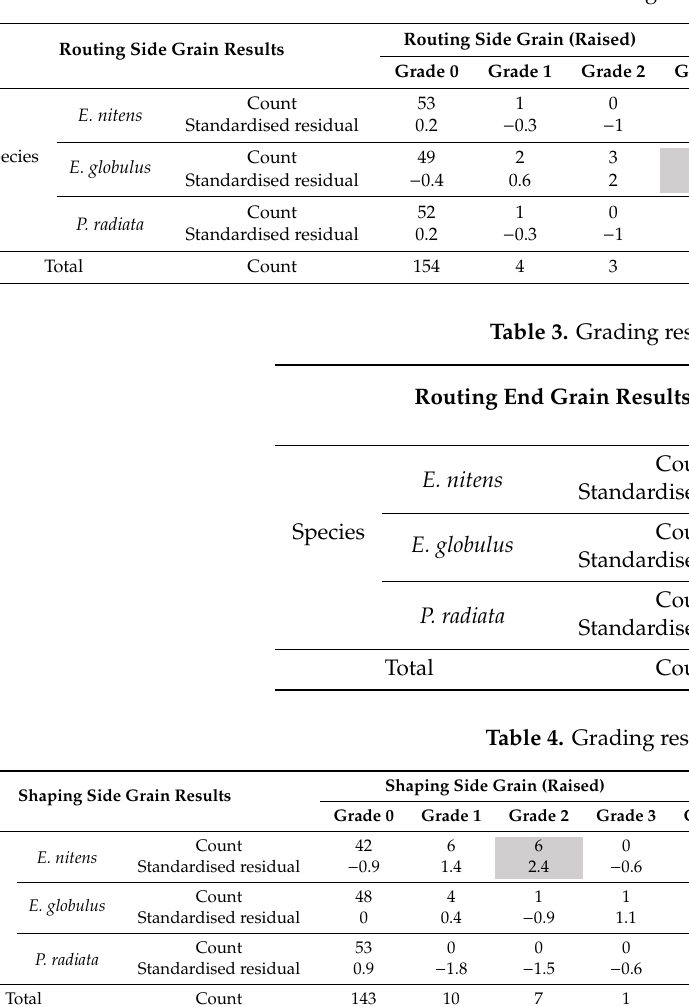
Table 2. Grading results according to routing side grain.